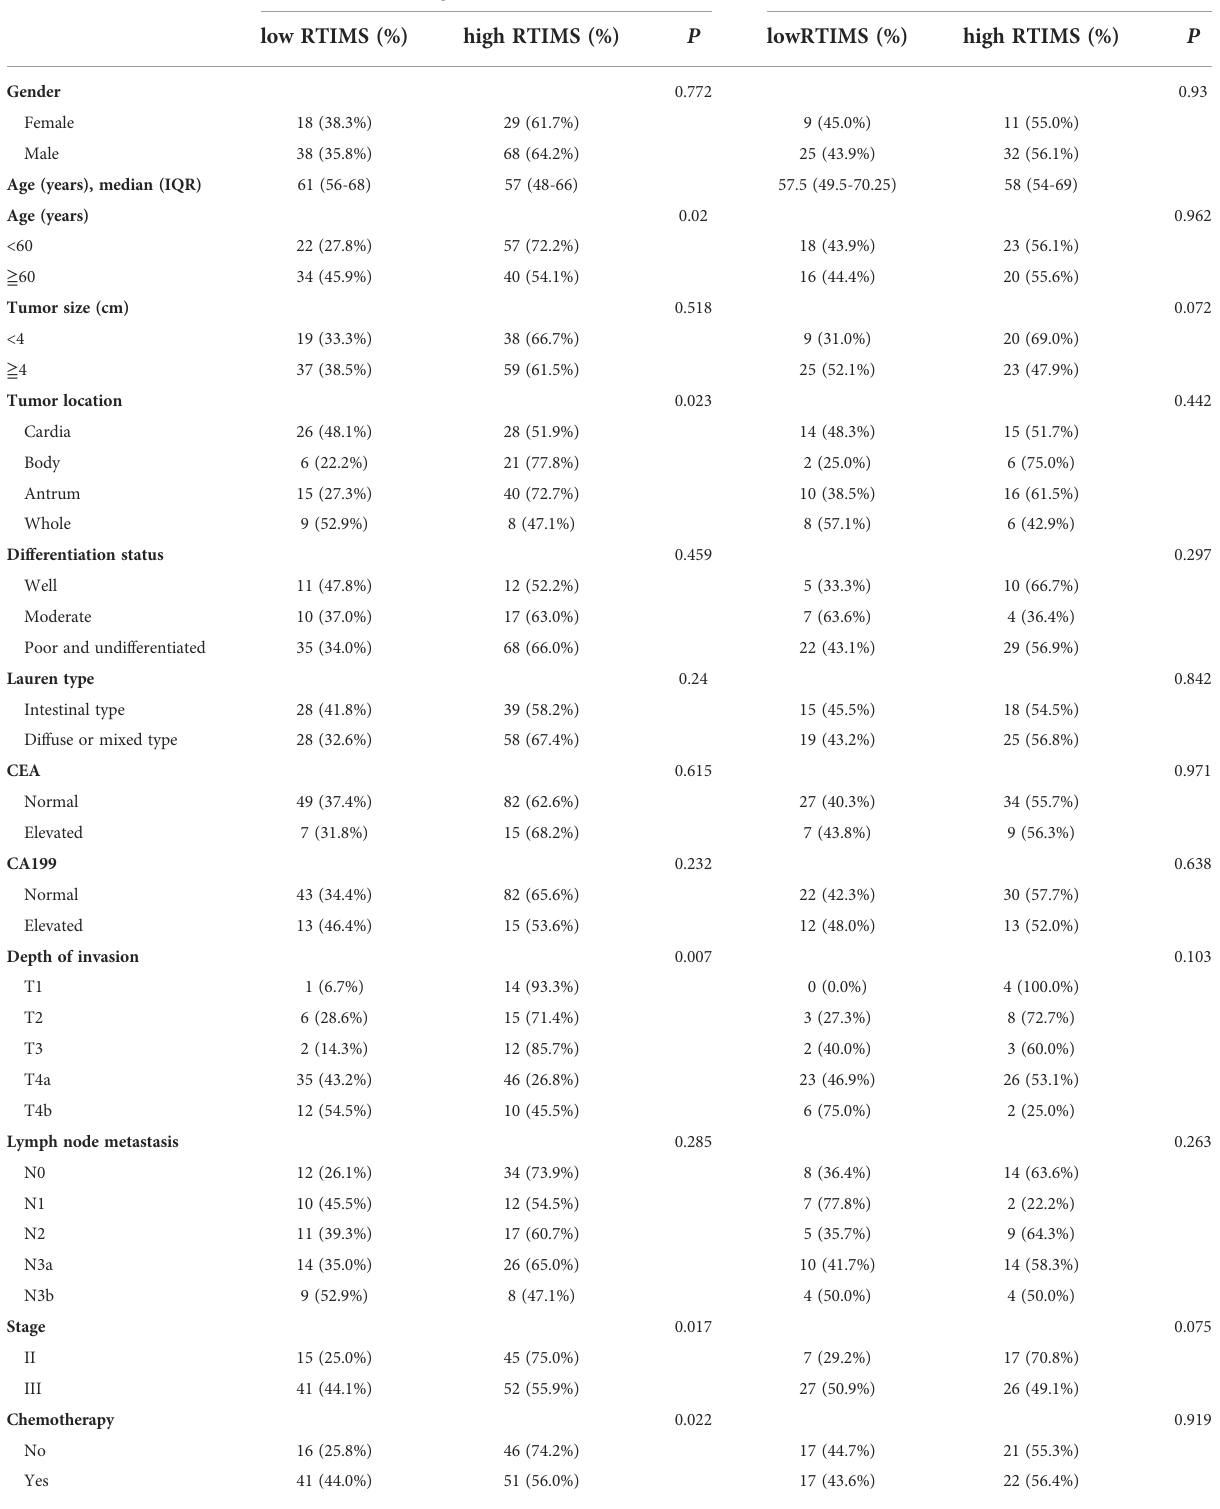
TABLE 1 Clinical characteristics of patients according to the radiomics signature in the training and external validation